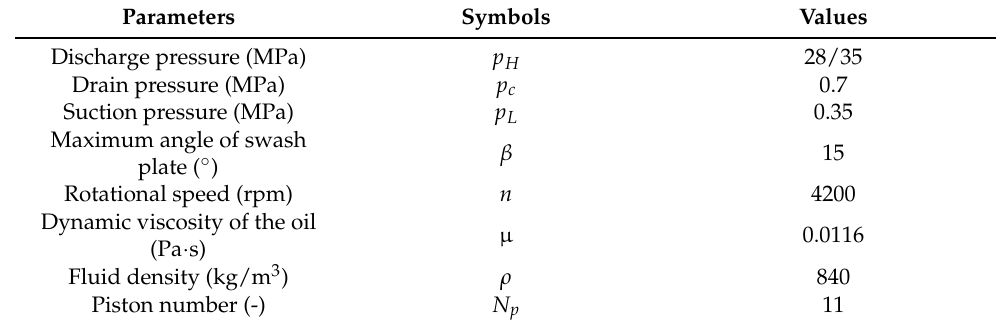
Table 1. Parameter